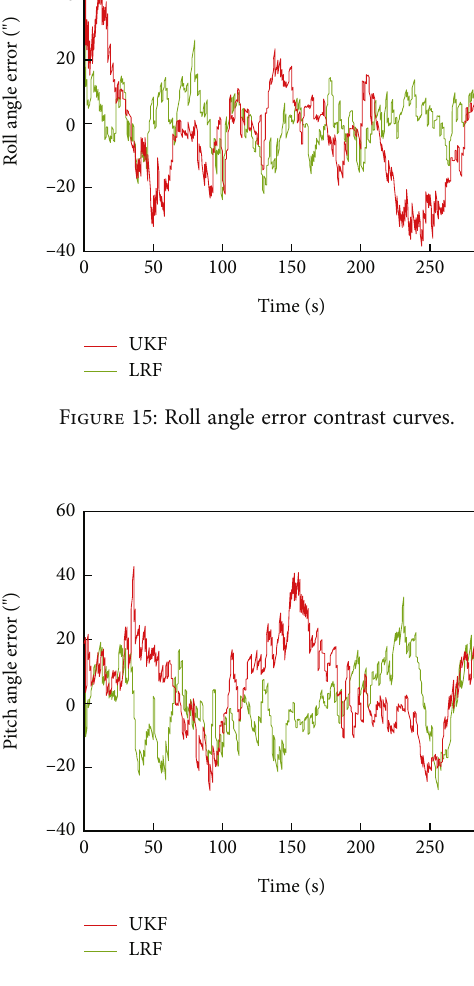
Figure 14: Z -axis velocity error contrast curves.